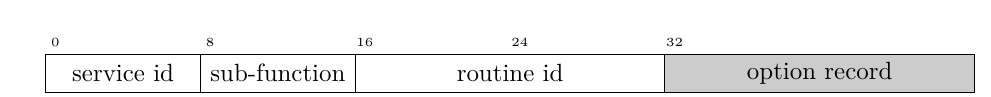
Figure 5: A UDS RoutineControl request message. The default service identifier for RoutineControl is 0x31 . Common sub-functions include start routine ( 0x01 ), stop